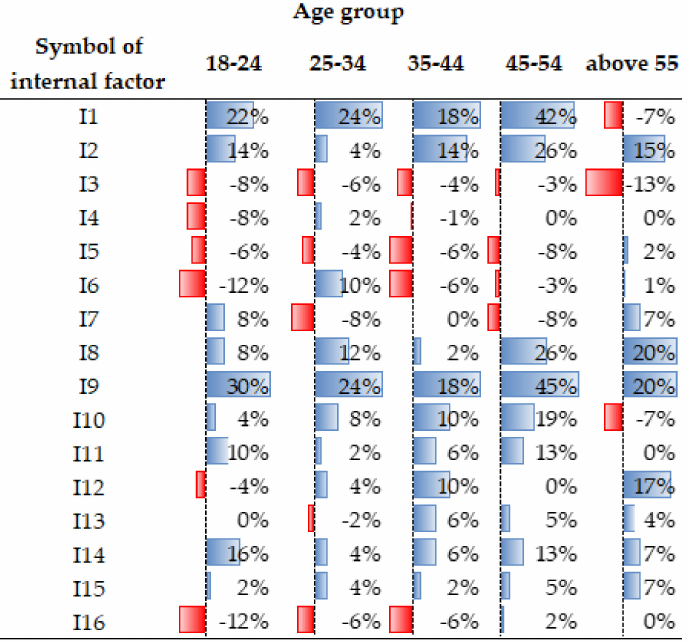
Figure 9. Differences in the perception of internal factors, broken down by age groups. Source: own